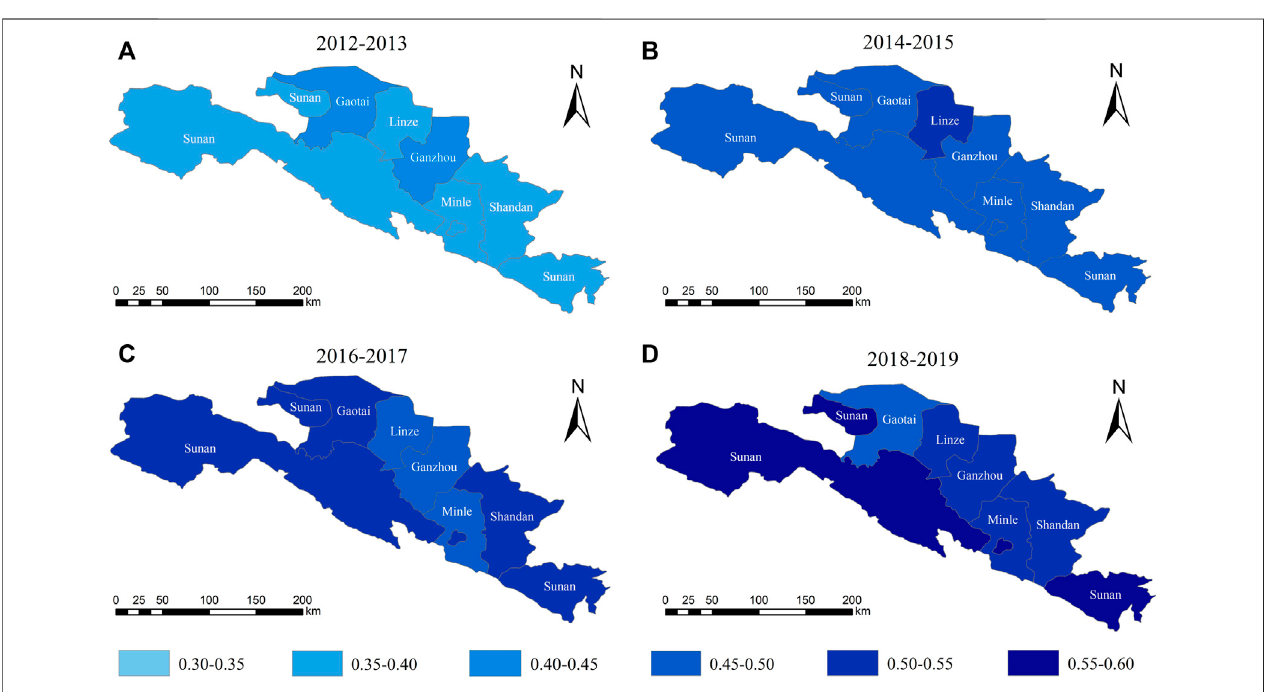
FIGURE 5 | (A – D) represent different periods of 2012 – 2019, which divided in a two-year cycle. Spatial variation of WLCD in Zhangye in different years.